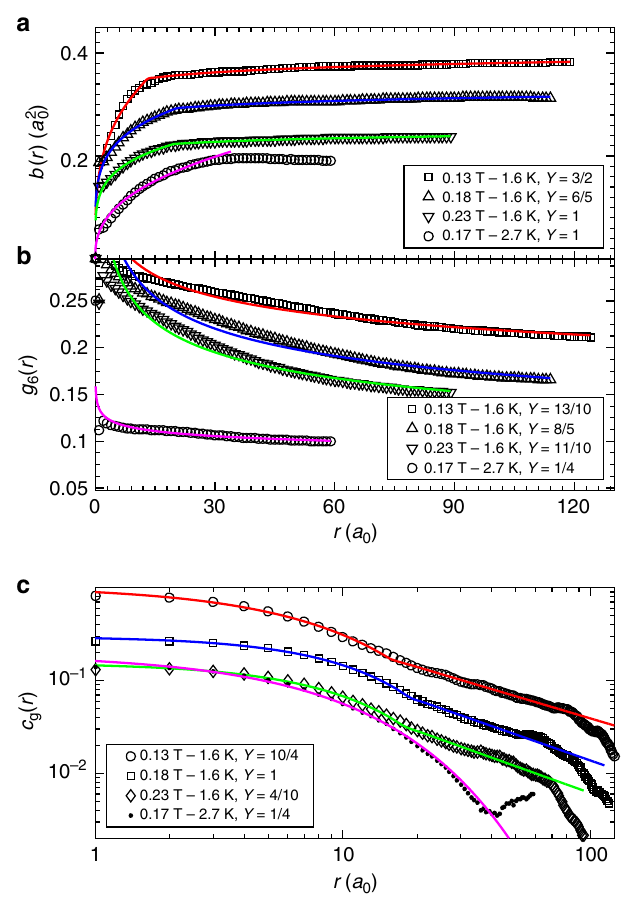
Fig. 8 In-plane correlations educed by reverse Monte Carlo re fi nement. Correlation functions calculated from simulated vortex ensembles (open symbols) that reproduce the neutron scattering data in Fig. 7. For clarity curves are offset with a multiplication factor Y . ( a ) Displacement correlator D E b ð r Þ ¼ u j (cid:2) u l ð Þ 2 . ( b ) Hexatic orientational order g 6 ð r Þ ¼ e i 6 θ j (cid:2) θ l ð fi tted with a single algebraic decay / r (cid:2) η 6 . ( c ) Translational order c (cid:9) and b ( r ) comprise three regimes in the Bragg glass picture: the e i g : u j (cid:2) u l ð Larkin, random manifold and Bragg glass regimes (see text). Here the Larkin regime lies at indiscernibly small length scales and two-part functions fi t b ( r ) and c g ( r ) (solid lines) for the three datasets at 1.6 K. For the 0.17 T, 2.7 K dataset, which lies close to the order-disorder line, a single function fi ts c g ( r ) corresponding to the random manifold